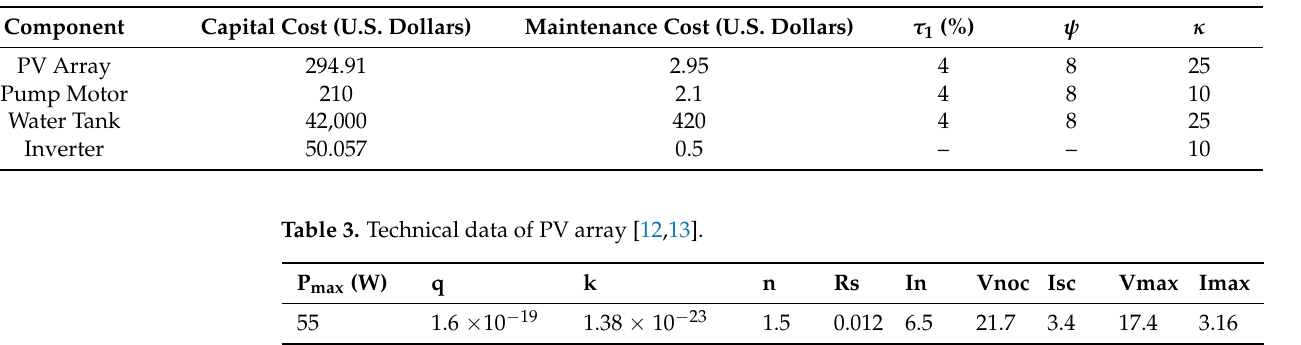
Table 2. The cost data of the system [11–13].